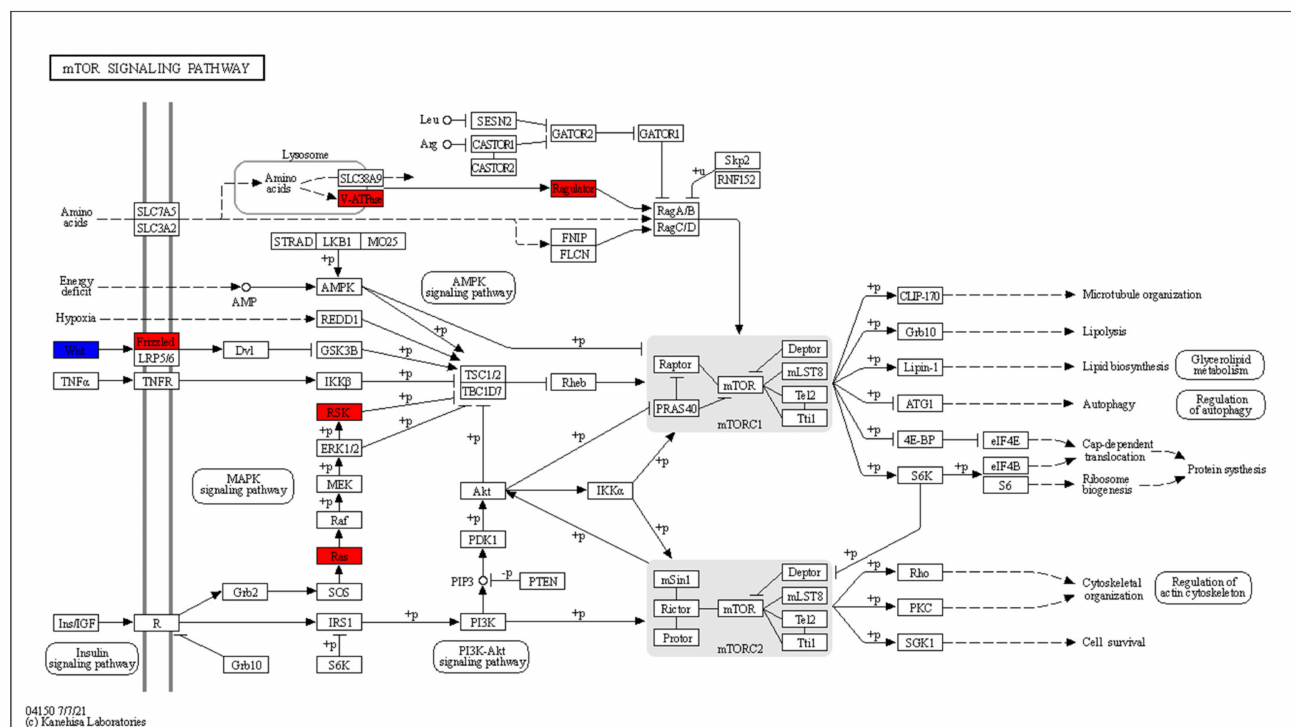
Figure 13. The differentially expressed genes of RA CD8 + Tem cells in the mTOR signalling pathway. Red indicates upregulated genes and blue indicates downregulated